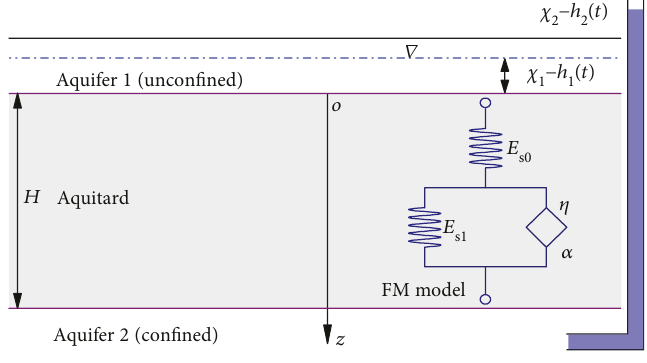
Figure 1: Illustration of the aquifer system incorporating a fractional-derivative viscoelastic